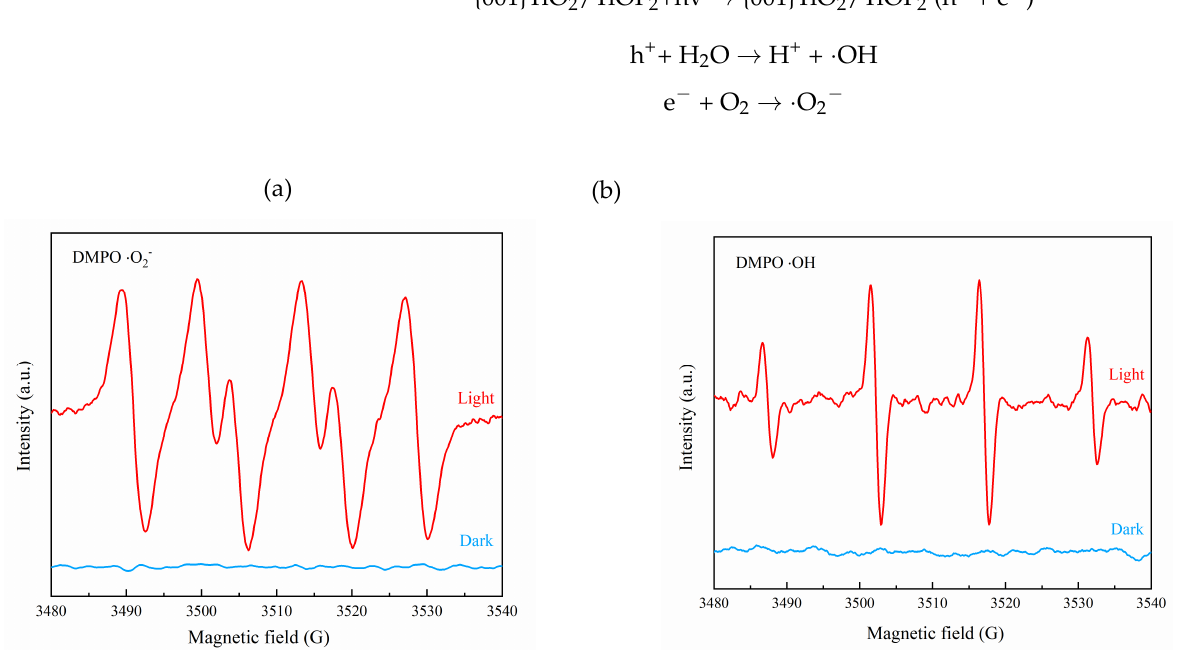
Figure 11. ESR profiles of DMPO- · O 2 − ( a ) and DMPO- · OH ( b ) of